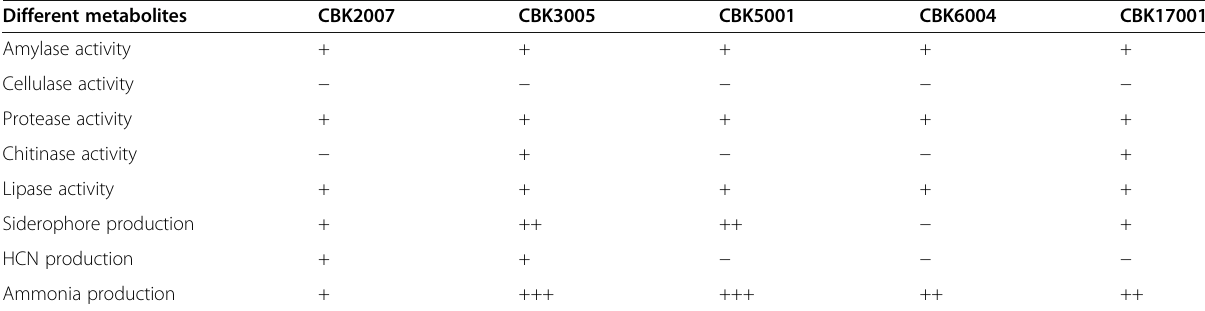
Table 4 Plant growth-promoting activity and hydrolytic enzyme production by the isolated strains Different metabolites CBK2007 CBK3005 CBK5001 CBK6004 CBK17001 Amylase activity +